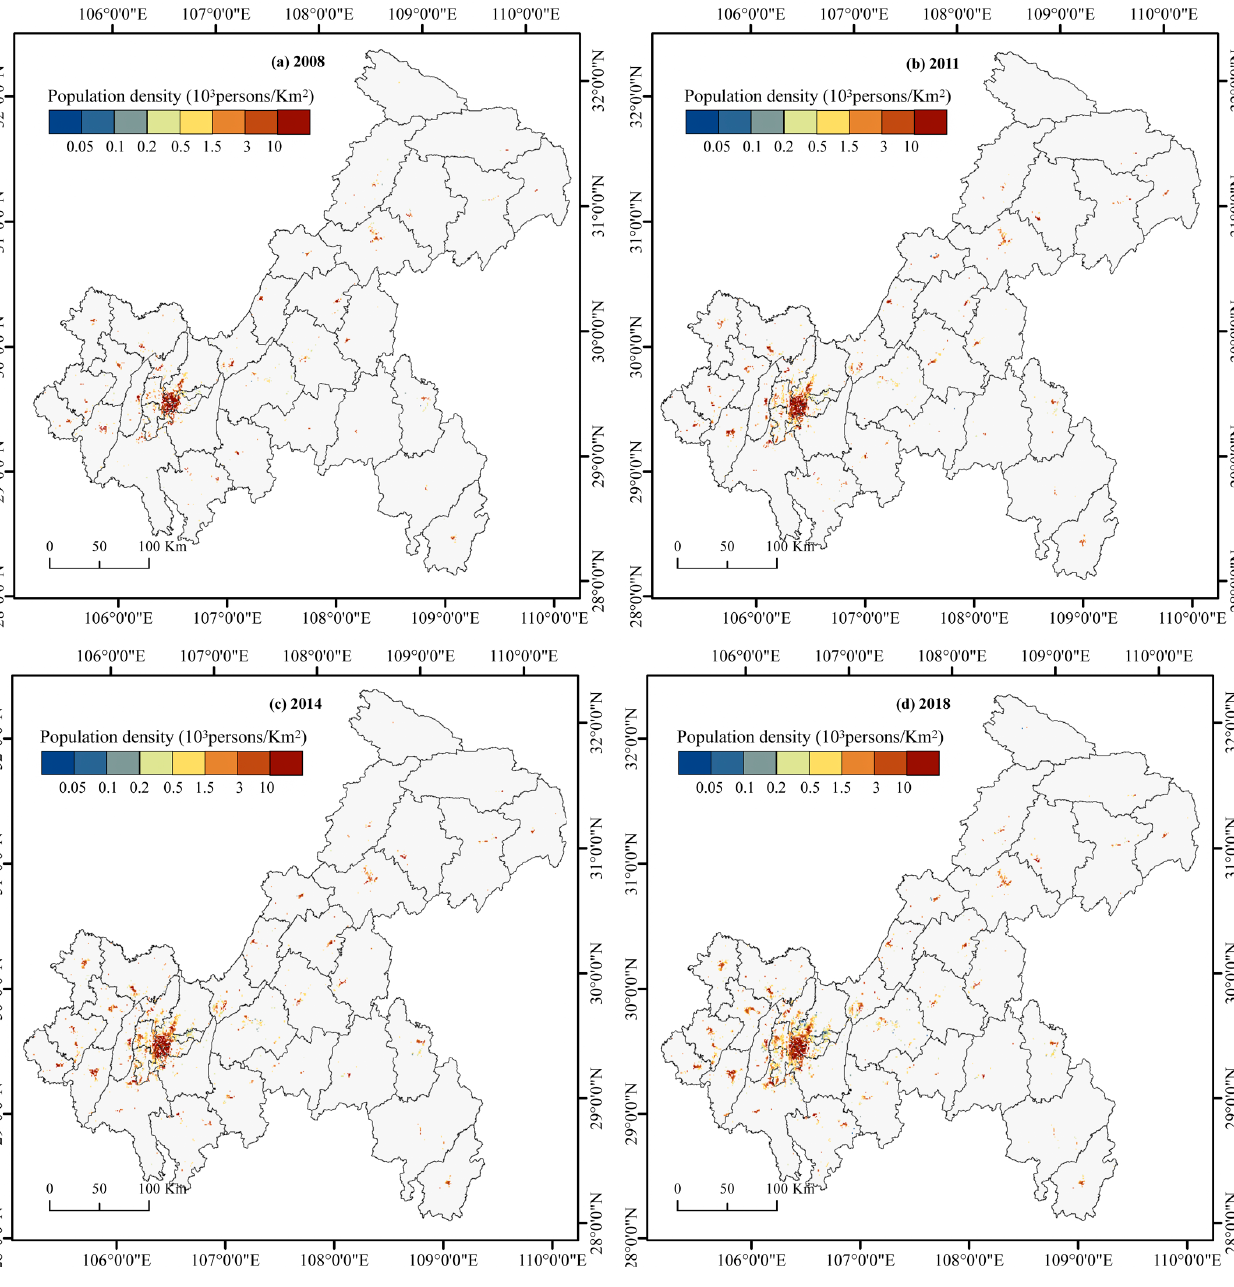
Figure 9. Spatial distribution of the population density of Chongqing in 2008 ( a ), 2011 ( b ), 2014 ( c ), and 2018 ( d ). and 2018 ( d